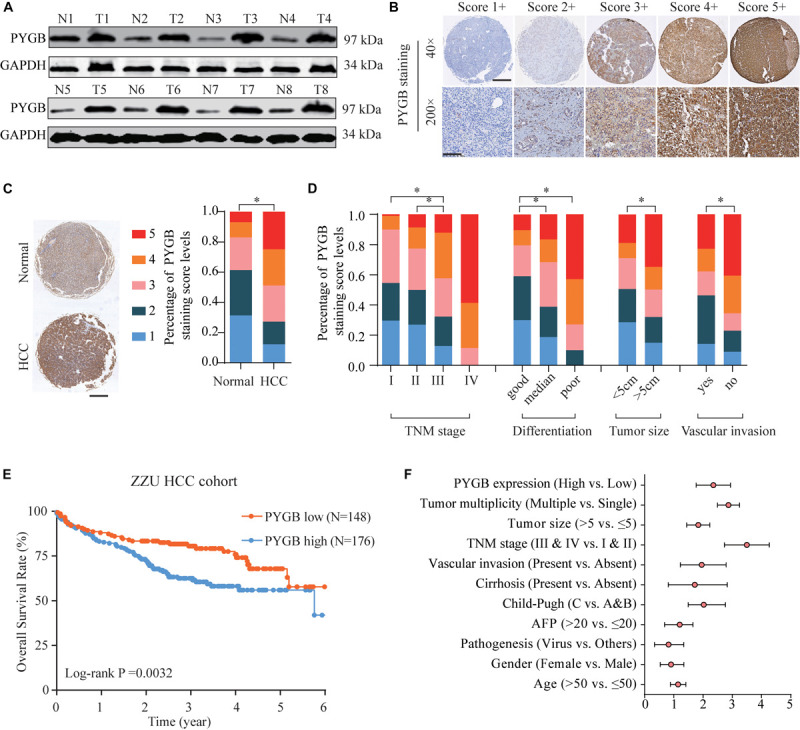
High PYGB protein expression is positively correlated with poor prognosis of HCC patients in ZZU HCC cohort. (A) PYGB protein expression was analyzed in paired tumor and adjacent non-tumor samples from 8 HCC patients by western blot. (B) PYGB protein expression was examined by IHC staining in ZZU HCC cohort and scored on a scale of 1–5 according to the staining intensity and area. (C) PYGB protein expression was analyzed in HCC tissues and adjacent non-tumor liver tissues based on the PYGB IHC staining score. (D) PYGB expressions were analyzed in HCC patients with different TNM stages, poor differentiation, tumor size and vascular invasion based on the PYGB IHC staining score. (E) The overall survival rates in HCC patients with high or low PYGB expression were analyzed by Kaplan-Meier analysis in ZZU HCC cohort. (F) Univariate and Multivariate Cox regression analysis of the clinico-pathological features and PYGB expression in ZZU HCC cohort. *p < 0.05.